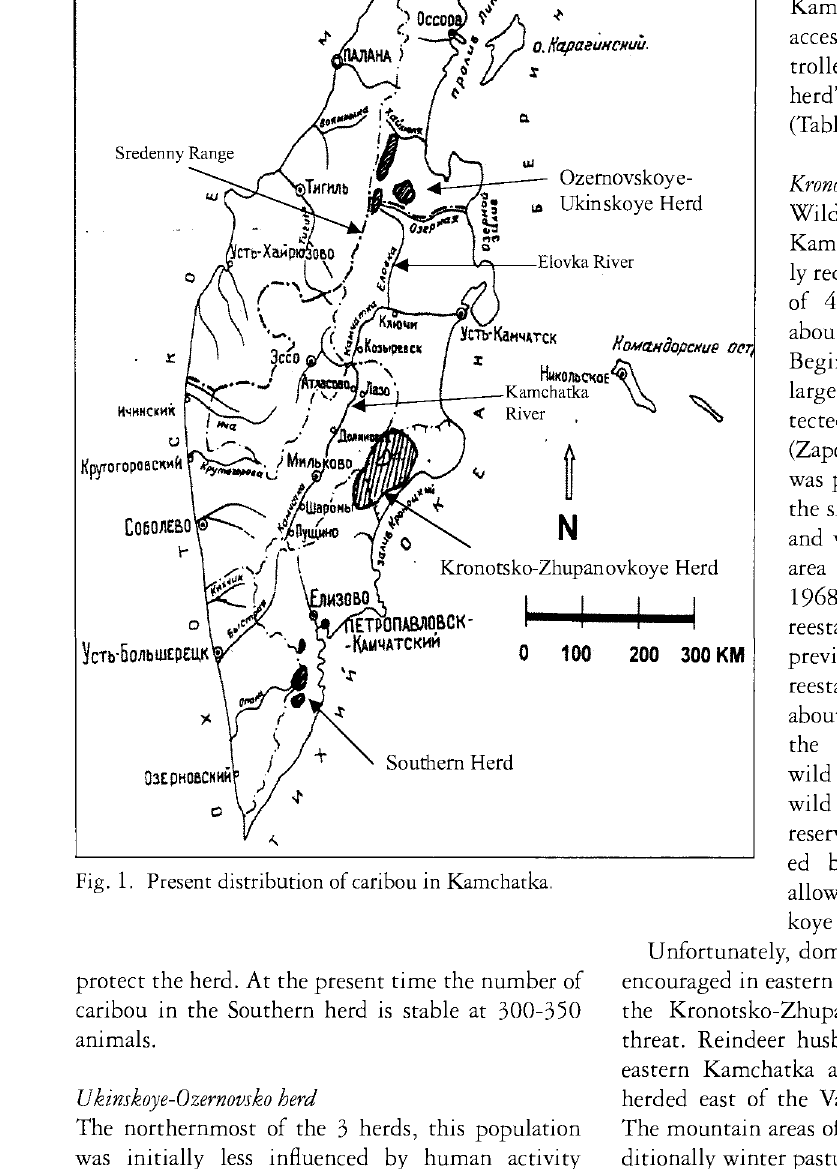
protect the herd. At the present time the number of caribou in the Southern herd is stable at 300-350